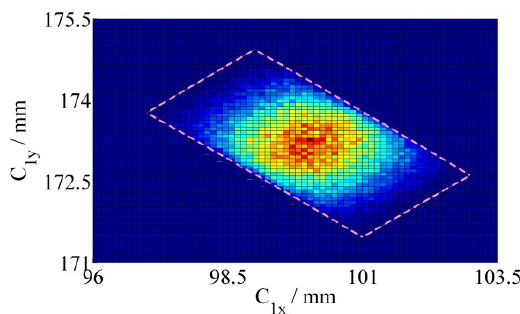
Figure 21. The theoretical boundary of C 1 .